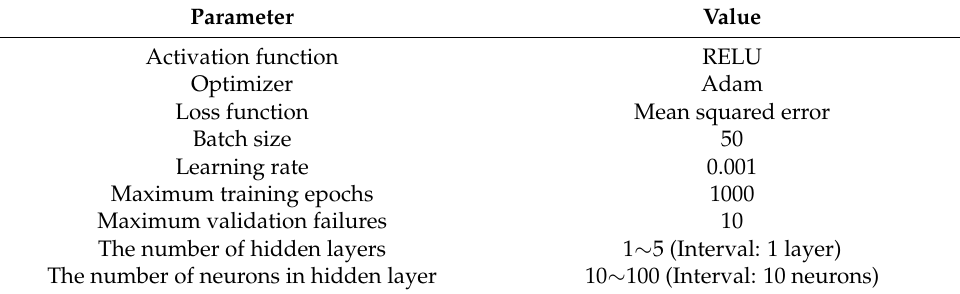
Table 7. Parameters of the ANN